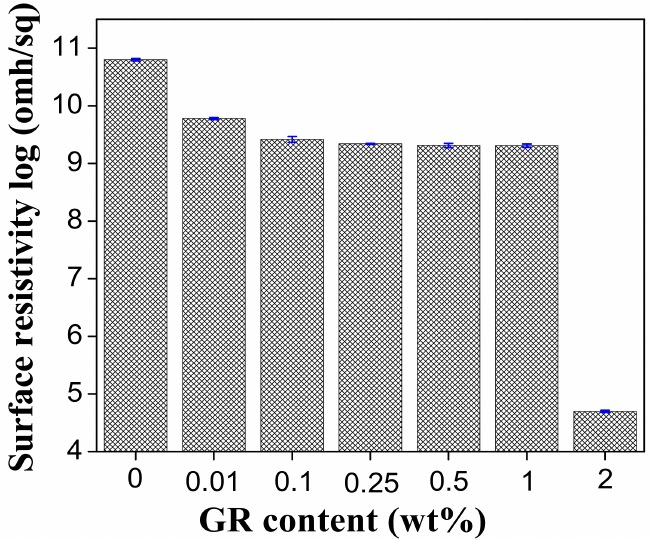
Figure 6. Surface resistivity of PVA/GR nanofiber films as related to the content of